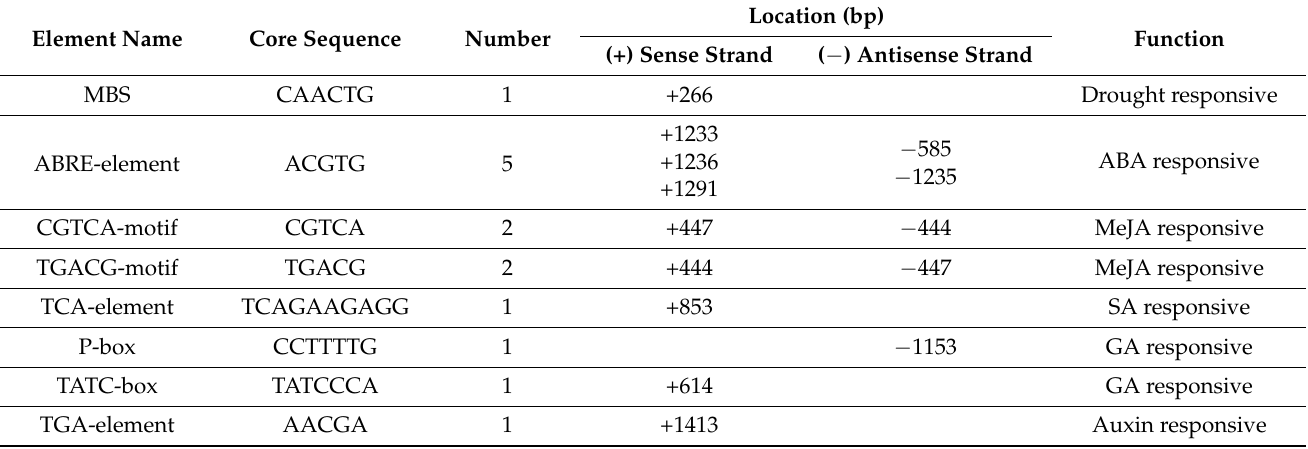
Table 1. Sequence, number, location, and function of cis -acting elements in GmTIP1;6 promoter.